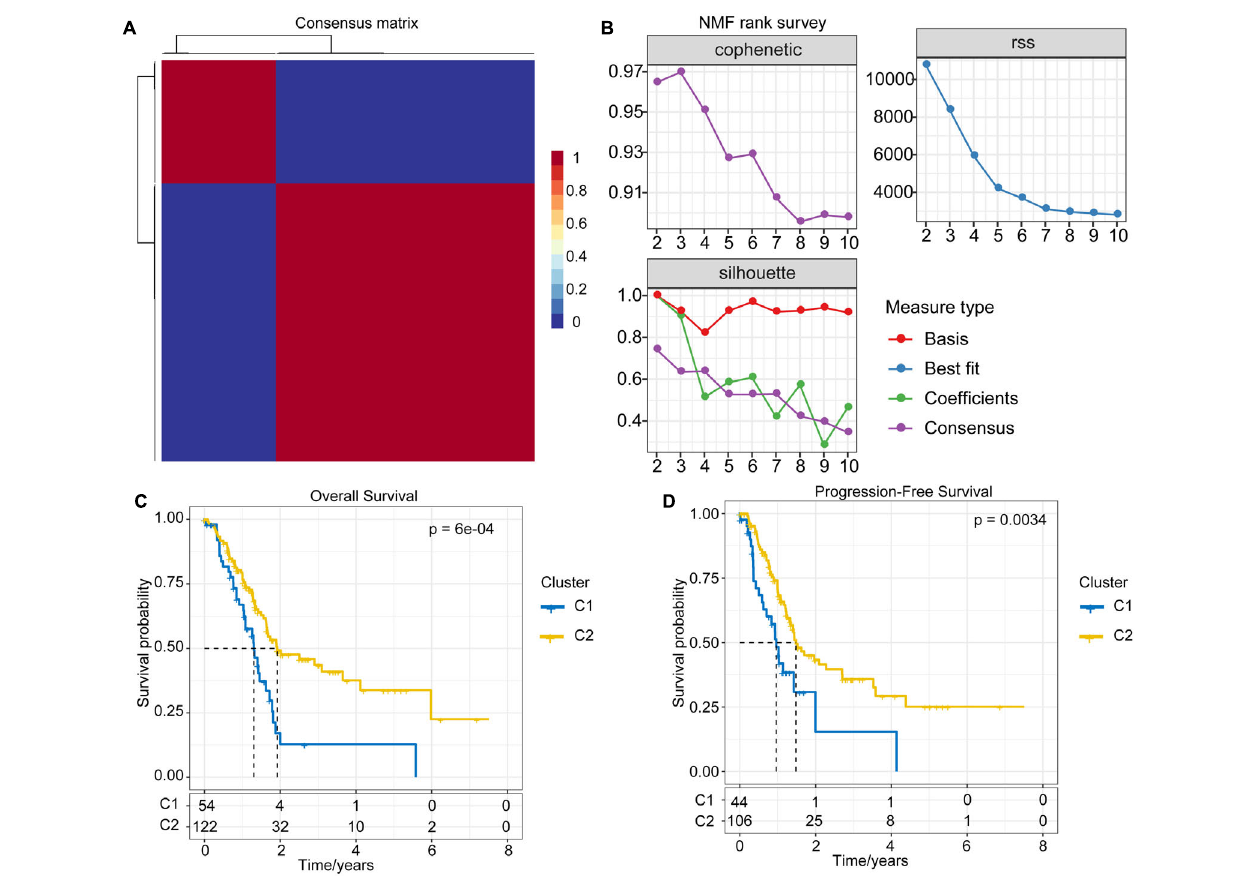
FIGURE 2 | NMF algorithm clustering and prognostic differences between subtypes. (A) Consensus map of NMF clustering. (B) The cophenetic, RSS and dispersion distributions with rank = 2–10; combining these indicators results in the optimal number of clusters of 2. (C) OS time prognostic survival curve of